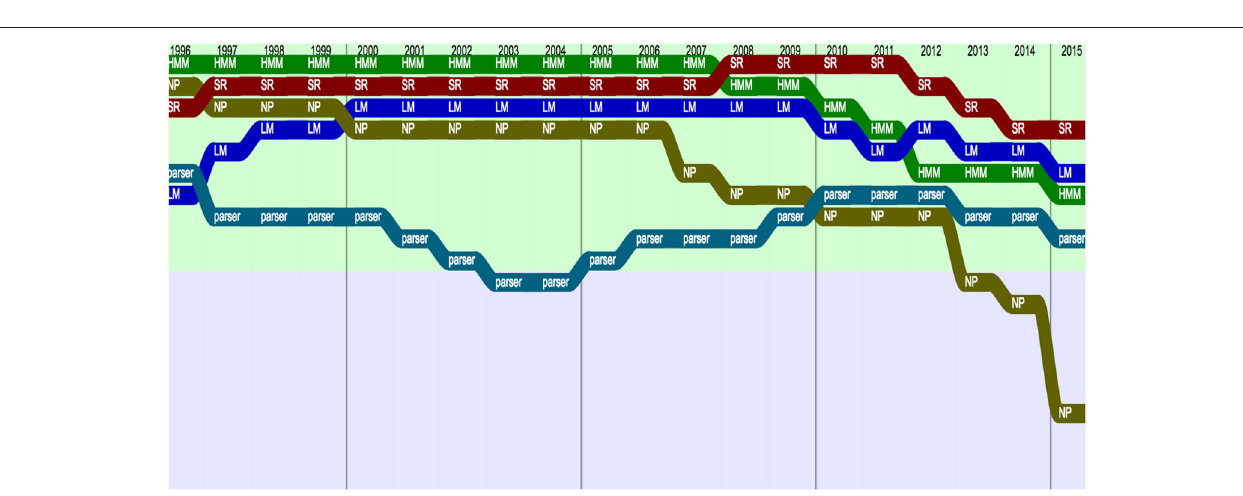
FIGURE 2 | Topics remaining popular (raw ranking, according to Frequency with